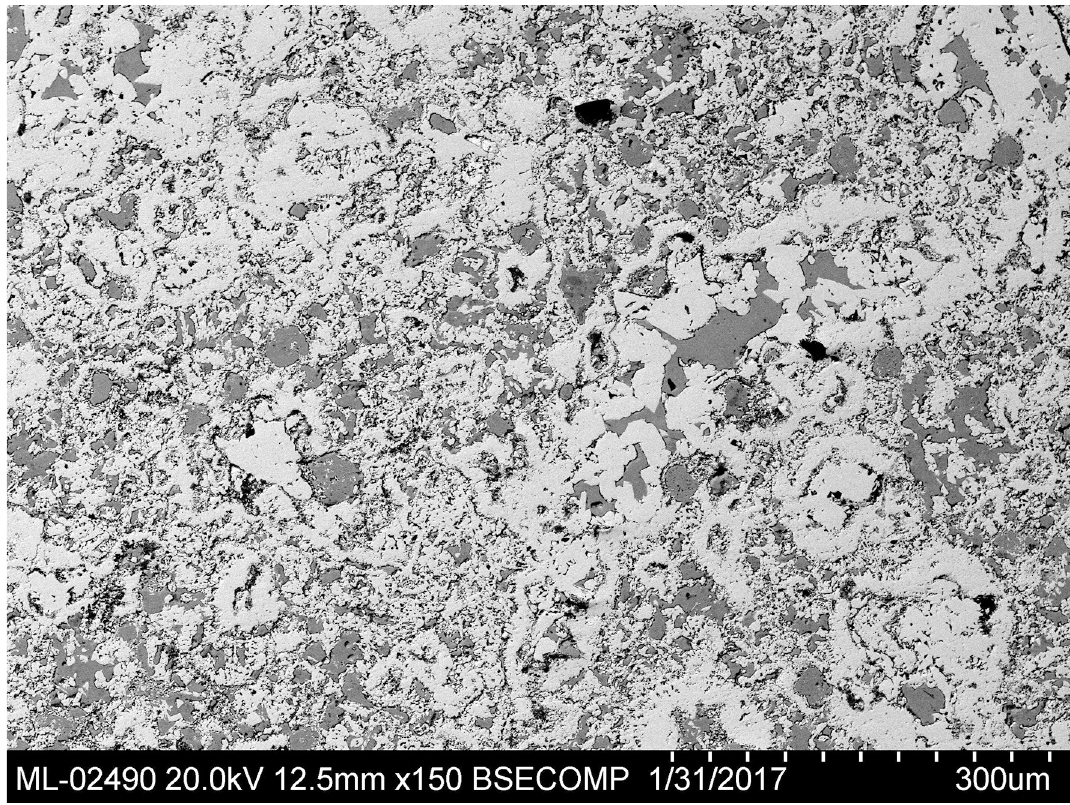
Fig 14. Aspect of the phase distribution in the core of the leaded lump Bleje ş ti 1–2. The white phase is anglesite, the grey phase is palmierite. SEM image, backscattered electrons (S. Rovira).